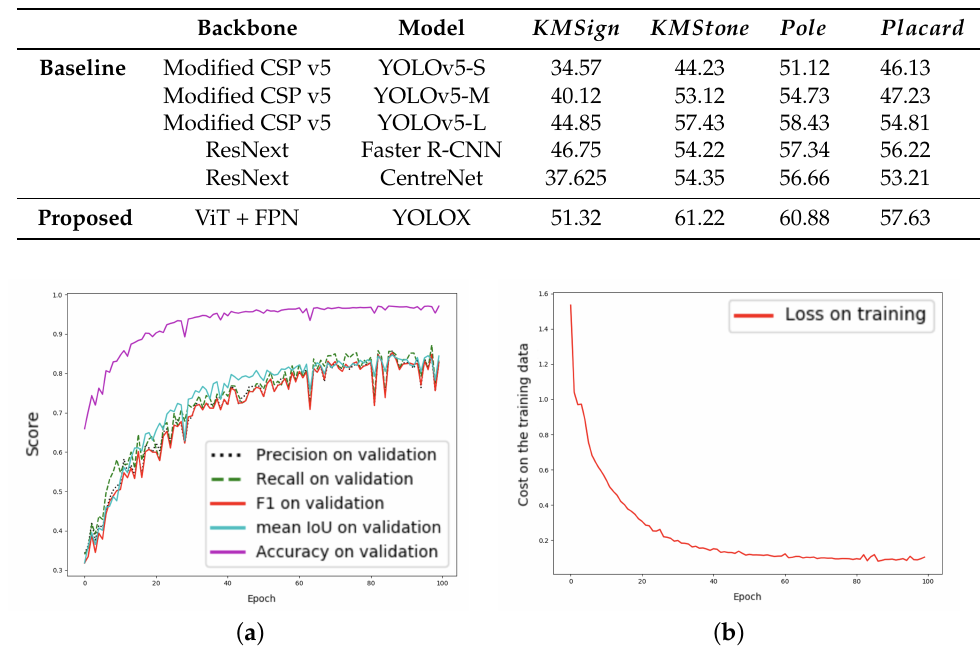
Figure 6. Graph (learning curves) of the Road Asset corpus of the proposed approach, “YOLOX-based Vision Transformer with FPN”; x refers to epochs, and y refers to different measures ( a ) Plot of model loss (cross-entropy) on training and validation corpora; ( b ) performance plot on the validation